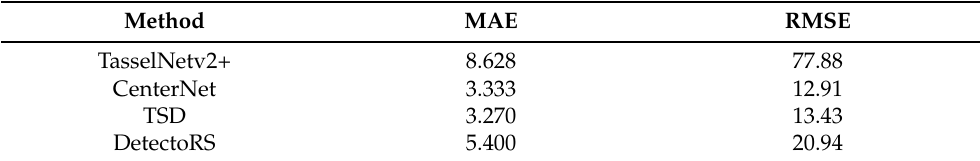
Table 4. Testing results for counting-based metrics.